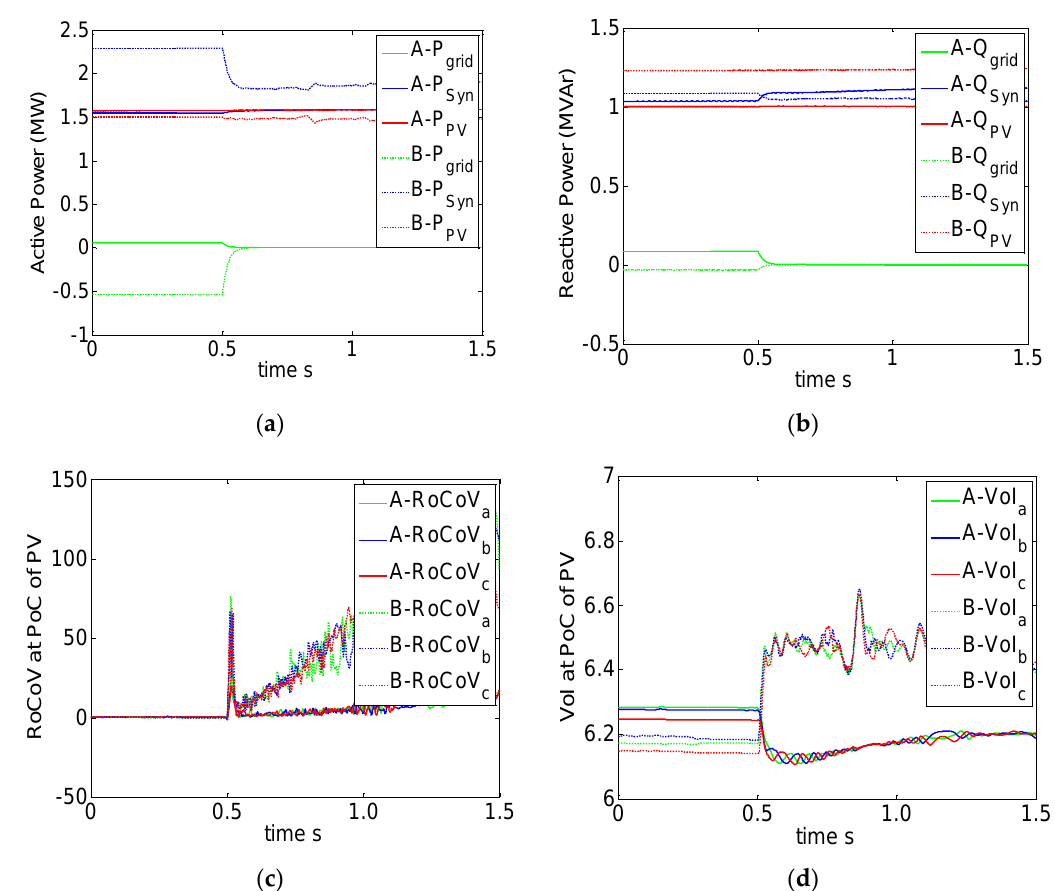
Figure 6. Islanding event case study ( a ) Active power outputs of distributed generations (DGs) and grid; ( b ) Reactive power outputs of DGs and grid; ( c ) Rate of change of the voltages for three phases at the point of connection (PoC) of the photovoltaic (PV), scenario A and B; ( d ) the ratio of voltage and current magnitudes (VoI) index at the PoC for PV.